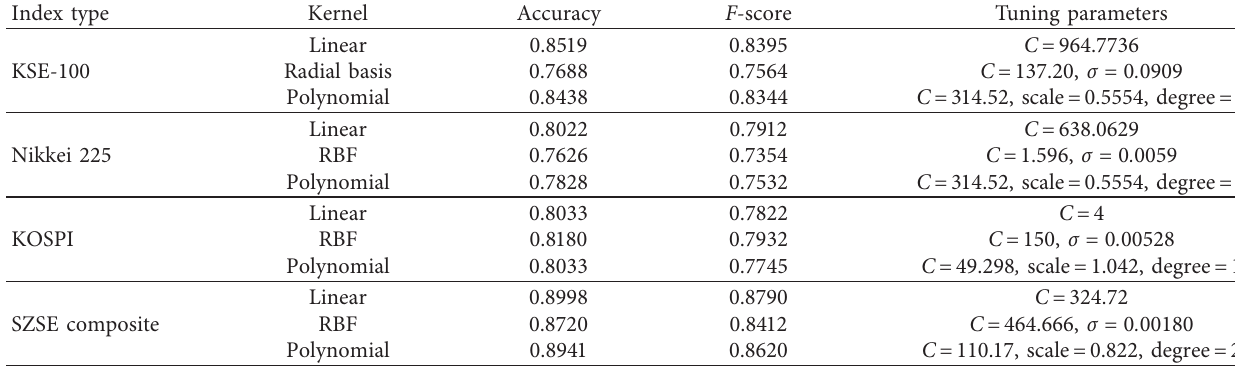
Table 11: Tuning parameter selection for the SVM model using 10-fold cross-validation.